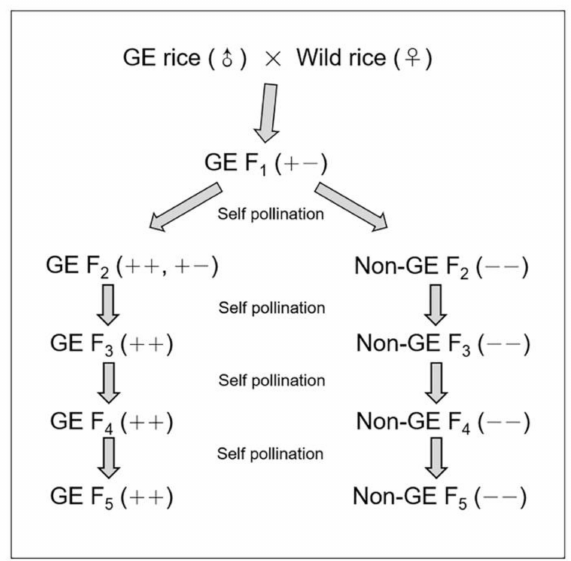
Figure 2. An illustration showing the production and pedigrees of GE rice (EP3) × wild rice (w1 or w2) hybrids and the derived F 2 –F 5 hybrid lineages through successive self-pollination. + + and + − indicate GE homozygous and heterozygous hybrids/lineages, respectively; − − indicates non-GE homozygous